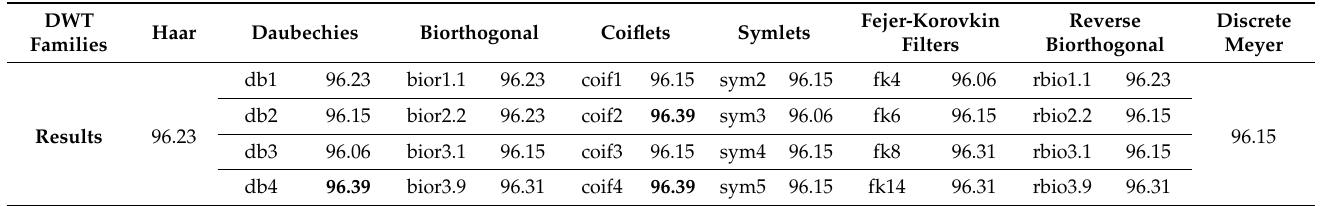
Table 4. Identification accuracies using several DWT families applied to the IITD database.